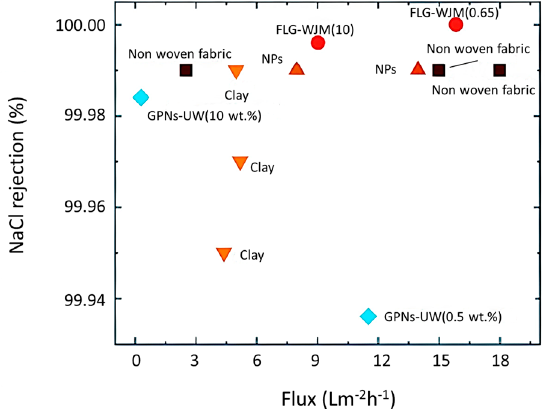
Figure 5. Productivity–efficiency trade–off diagram for PVDF membranes based on different fillers: graphene obtained by wet-jet milling process (red circles), graphene produced by ultrasonic waves (blue diamonds) [99], clay (orange triangles) [100], nonwoven fabric (dark brown squares) [101], and nanoparticles (NPs) (brown triangles) [102]. ( T FEED : ∼ 55 ◦ C, except for the nanoparticles T FEED : = 70 ◦ C). Reprinted from ref. [97] (Open